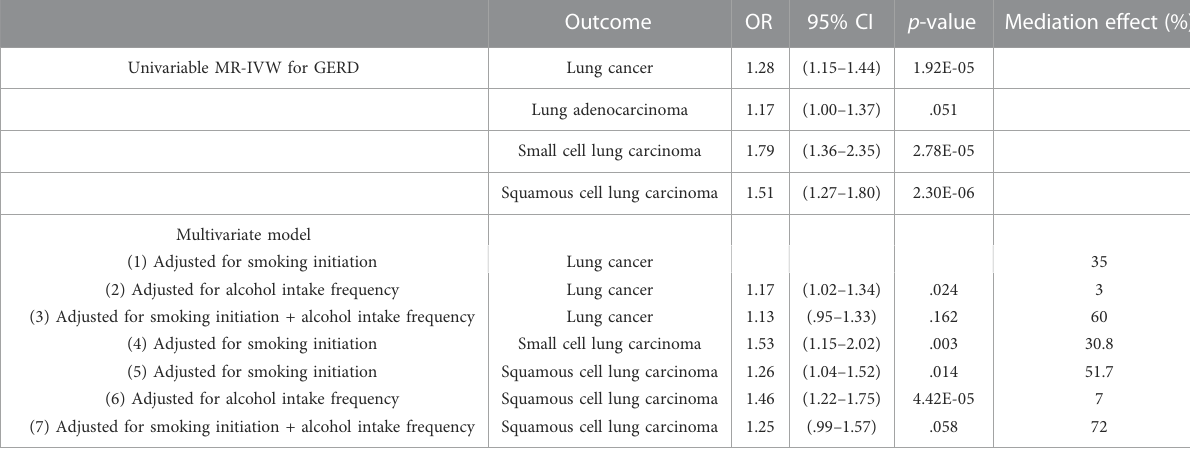
TABLE 3 Multivariate separate-sample MR analysis of the effect of GERD on lung cancer and